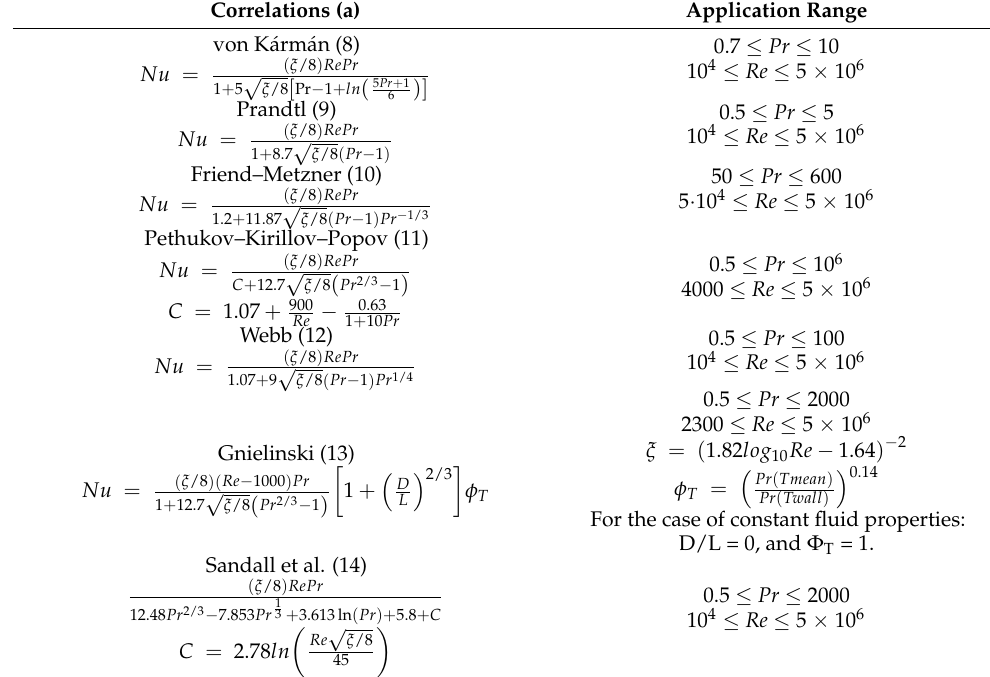
Table 2. Correlations for Nu number containing the friction factor